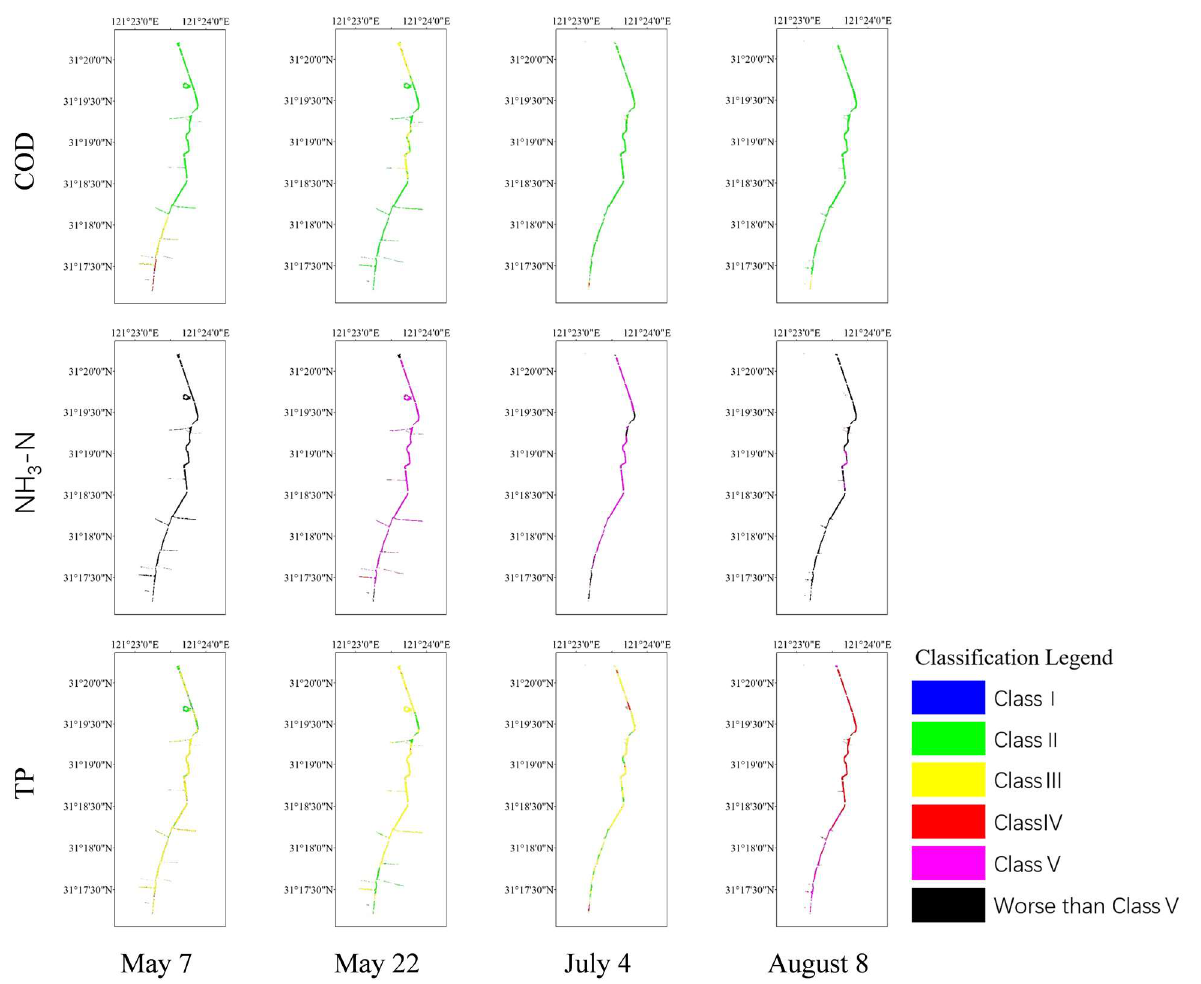
Figure 5. Multi-temporal water quality classification results of Taopu